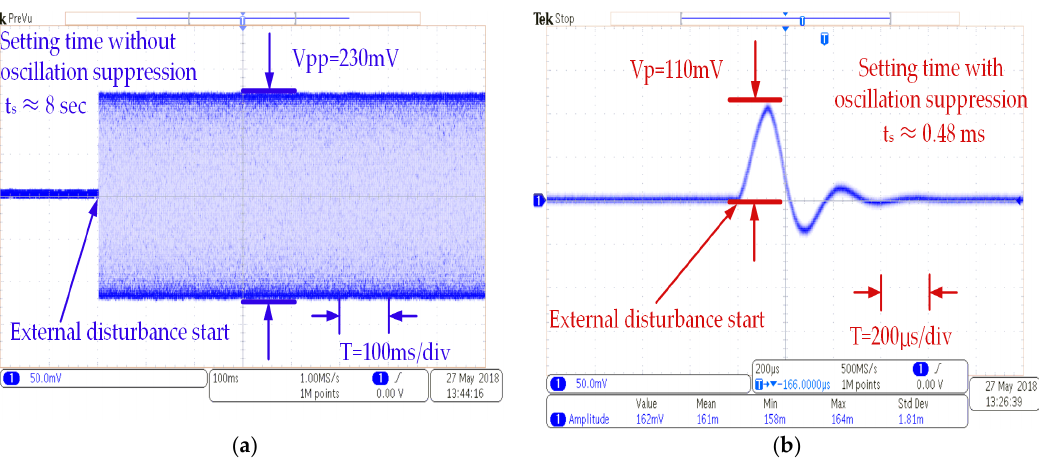
Figure 12. Transient response of the zero angular rate output: ( a ) without and ( b ) with oscillation suppression electronics.